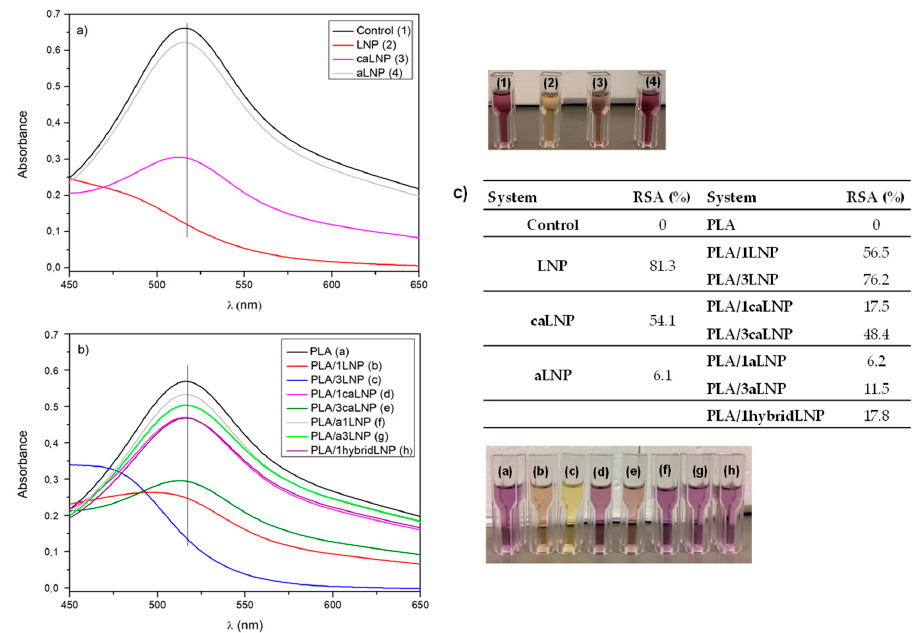
Figure 6. Antioxidant activity evaluated by absorbance of DPPH at 517 nm: ( a ) lignin nanoparticles; ( b ) PLA and PLA nanocomposite films and ( c ) adical scavenging activity (RSA) values of PLA and PLA nanocomposite films.